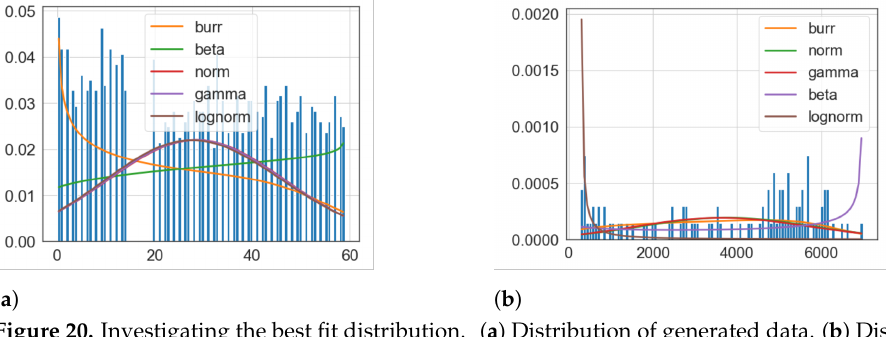
Figure 20. Investigating the best fit distribution. ( a ) Distribution of generated data. ( b ) Distribution of real data.